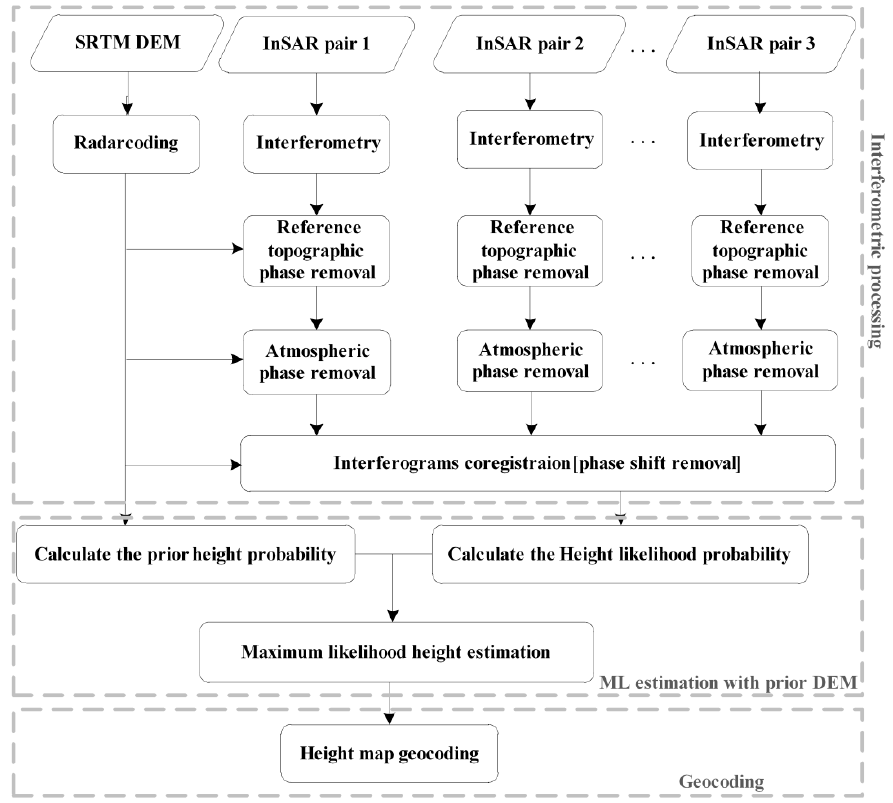
Figure 1. Flowchart for spaceborne multi-baseline InSAR DEM generation.